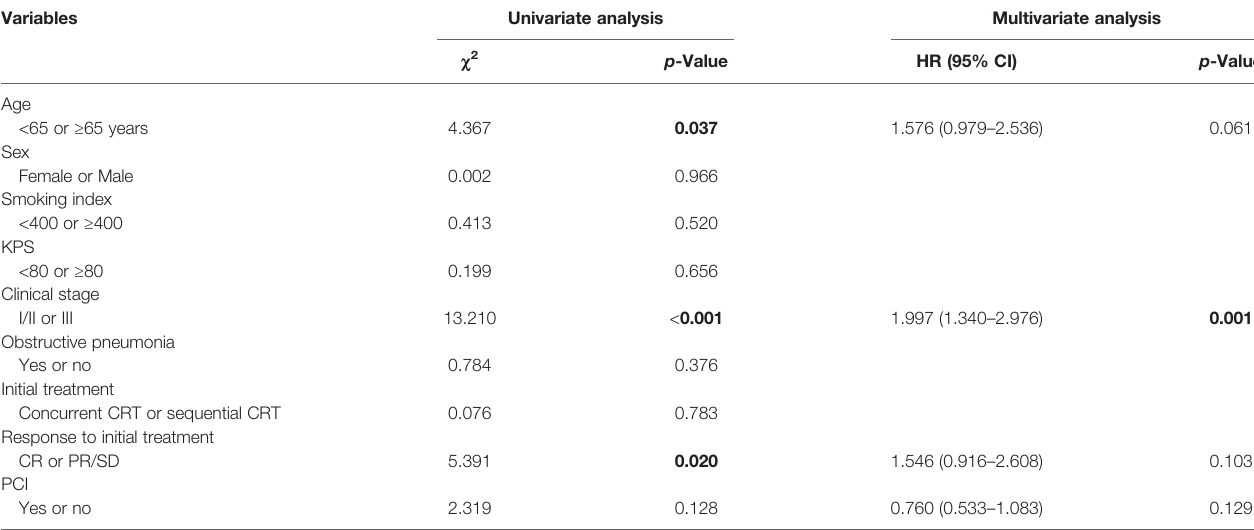
TABLE 3 | Univariate and multivariate analyses of factors in fl uencing OS, after propensity score matching.